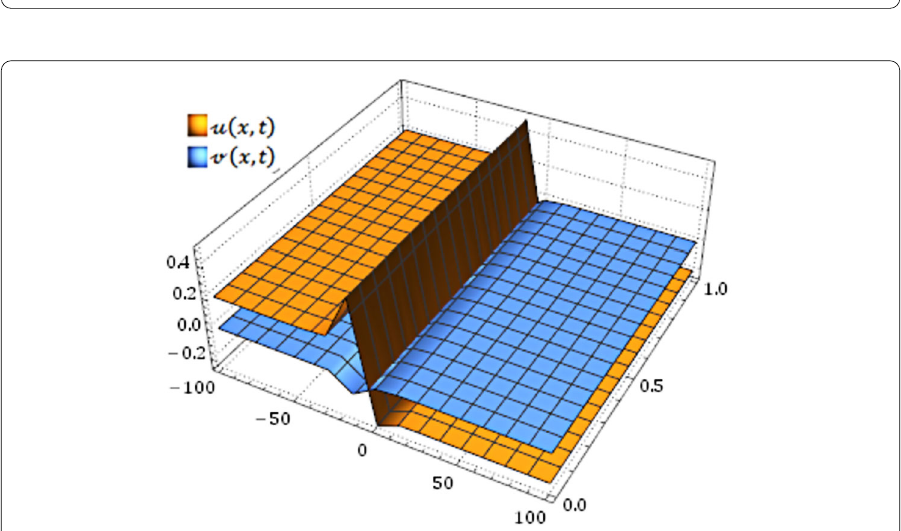
Figure 8 (cid:2) -curve drown for v ( x , t ) at n = 1 (left) and n = 2 (right) with different α when ω = 0.005, (cid:13) = 0.1, c = 10, x = 1 and t = 0.01 for Example